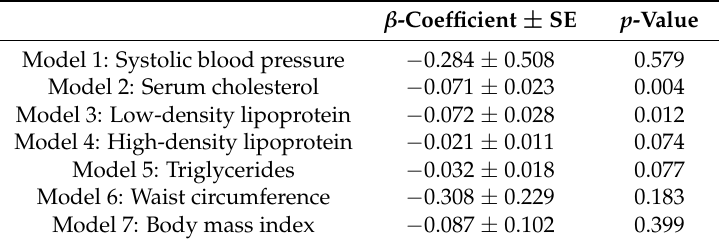
Table 6. The association between different clinical and anthropometric factors (dependent) and total adherence to Saudi dietary guideline score (independent). Results of multiple linear regression